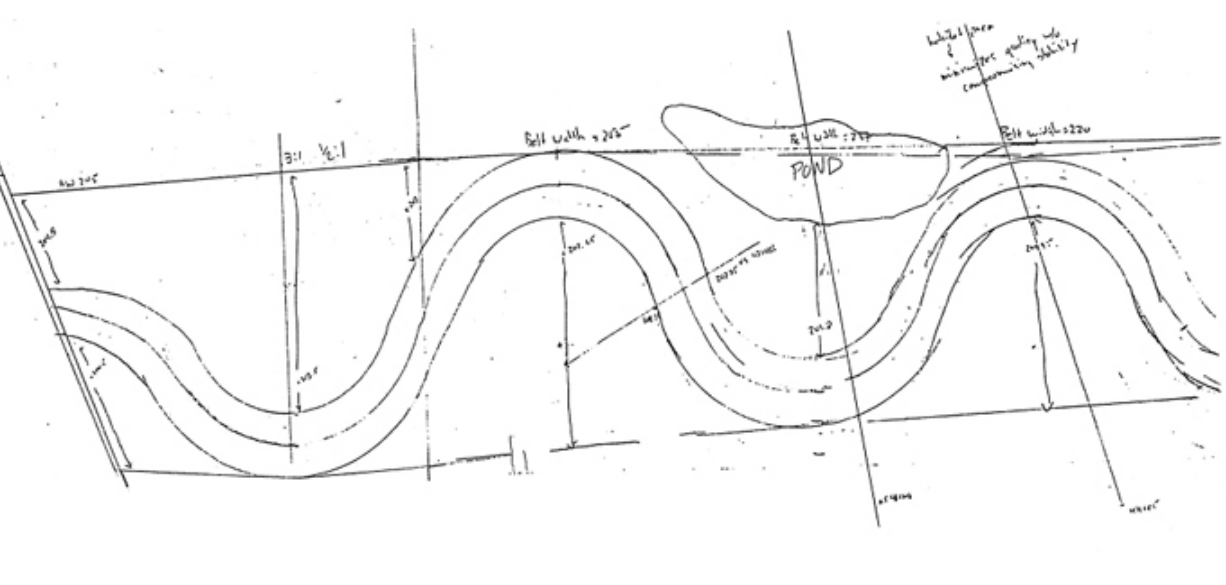
Fig. 7 . Plan for channel reconstruction, Uvas Creek, prepared by consultants (Source: Uvas Creek project files, City of Gilroy,